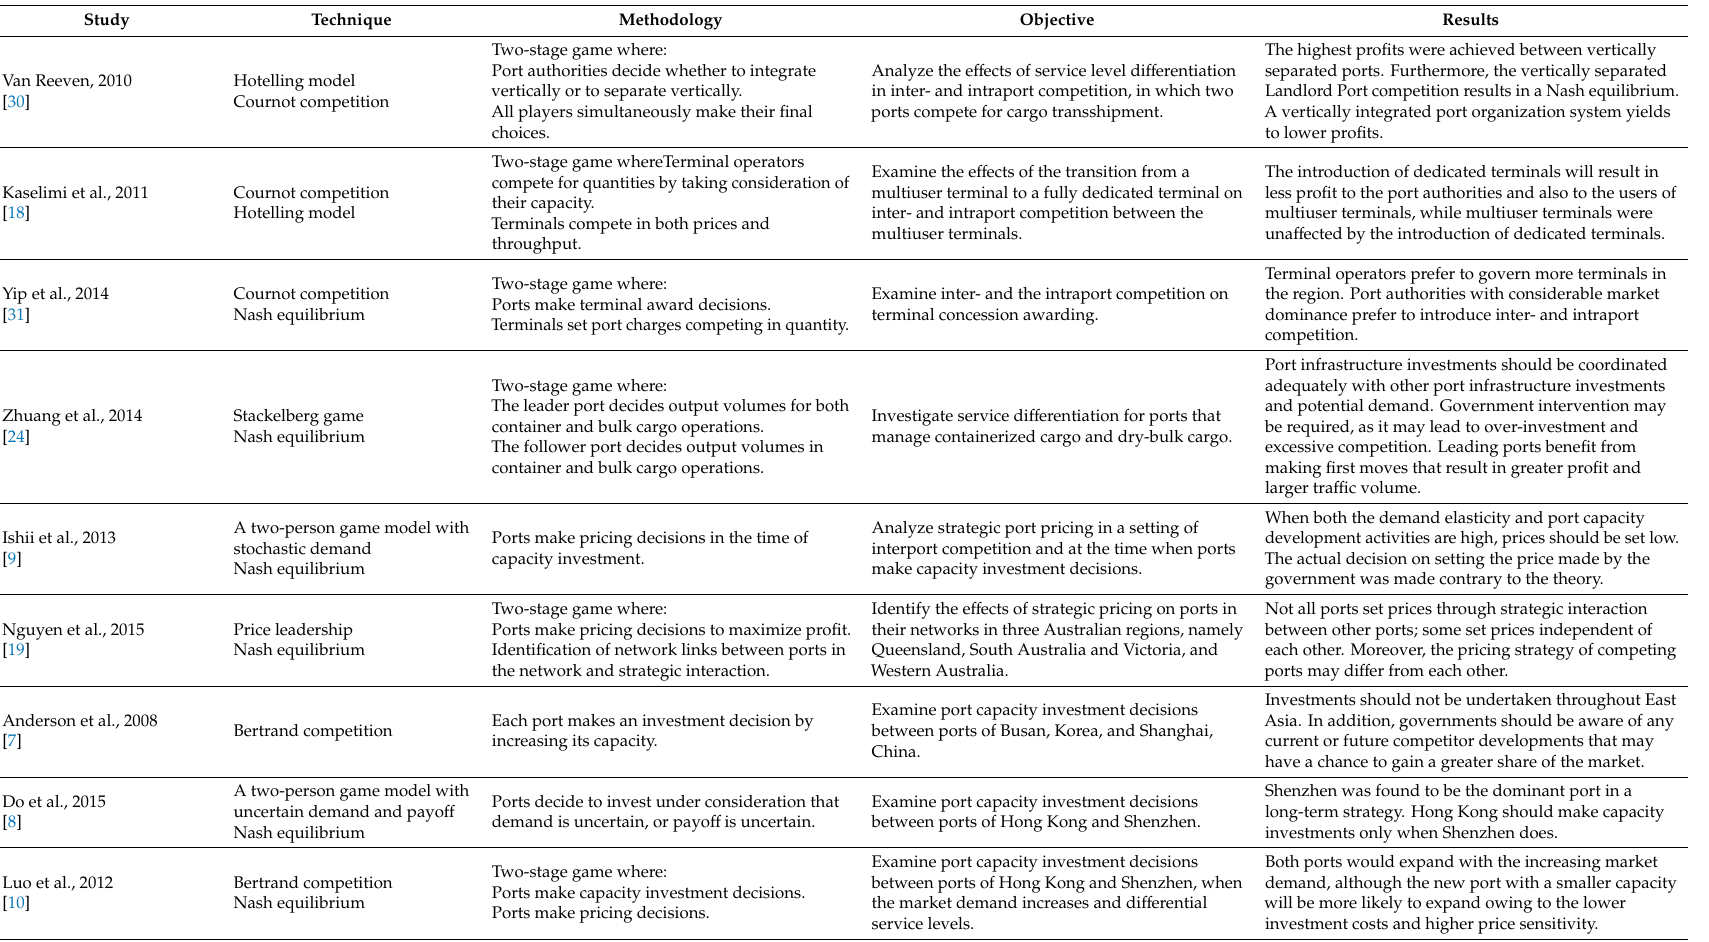
Table 2. Summary of Port and Container Terminal